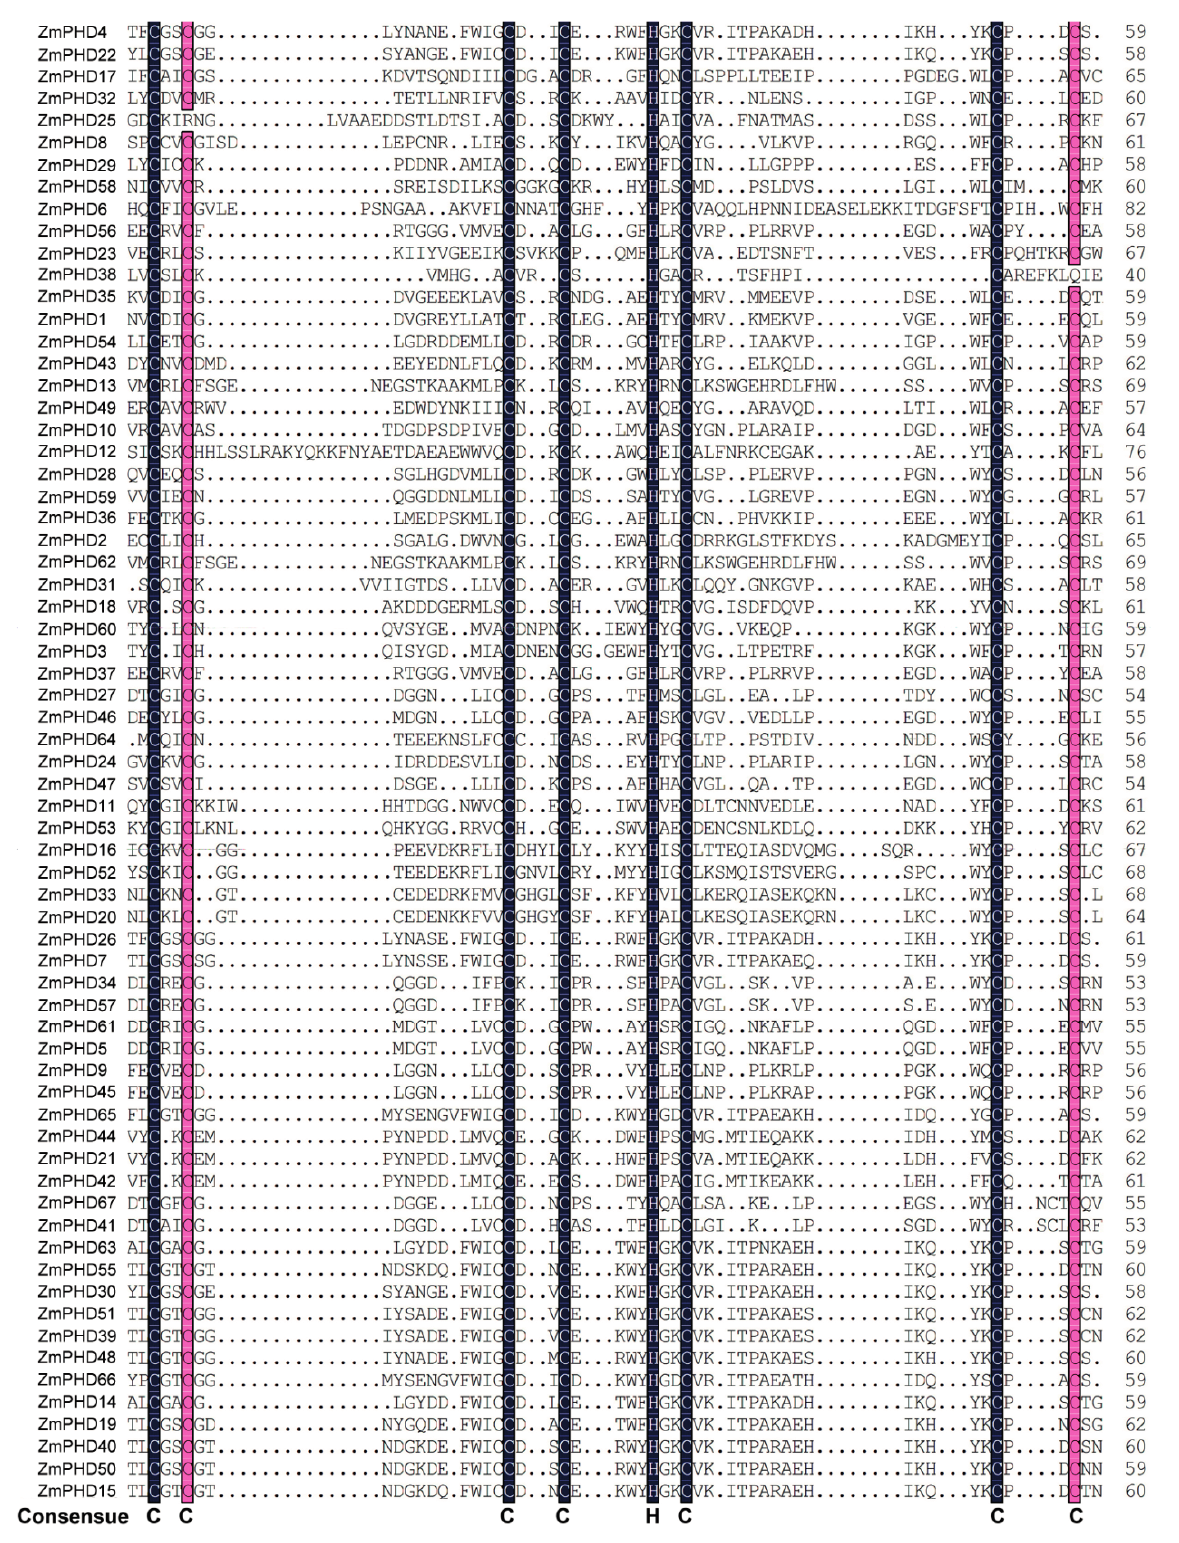
Figure 2. Multiple sequence alignment of PHD-finger domain of 67 maize PHD proteins. The shading of the alignment presents identical residues in black and similar residues in red, and the high conserved amino are marked at the bottom. The PHD-finger domain of each ZmPHD members is corresponding to the first PHD motif in the upstream of each PHD protein in Figure 3,